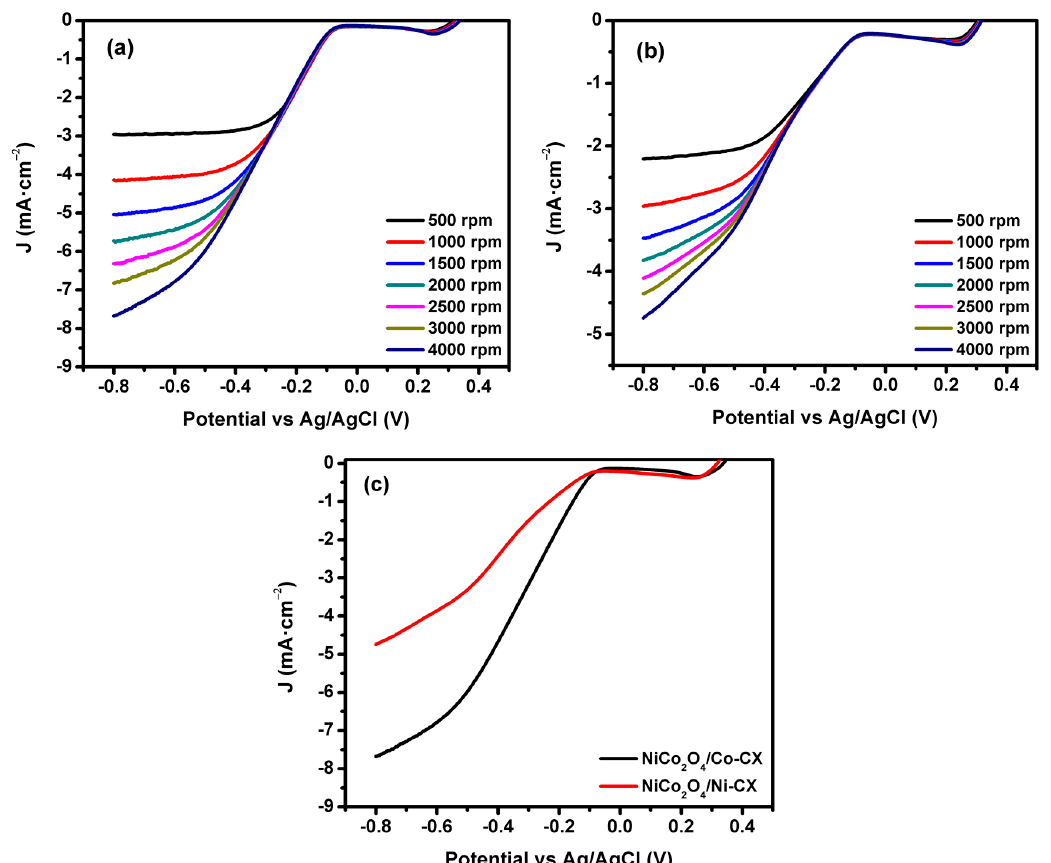
Figure 8. Linear sweep voltammograms (LSV) for ( a ) NiCo 2 O 4 /Co-CX, ( b ) NiCo 2 O 4 /Ni-CX at 5 mV.s − 1 with different speeds from 500 rpm to 4000 rpm and ( c ) comparing the LSV for NiCo 2 O 4 /Co-CX and NiCo 2 O 4 /Ni-CX at 4000 rpm.